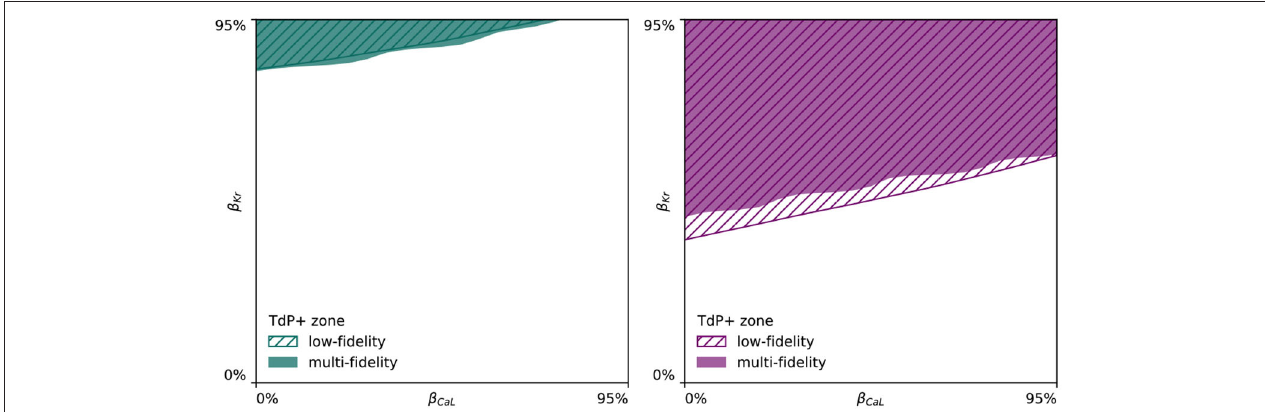
FIGURE A5 | Low- vs. multi-fidelity arrhythmogenicity mismatch. Mismatch between the low-fidelity midwall cell proxy and the full high-fidelity multiscale simulations for arrhythmogenic risk classification. For the male arrhythmogenic risk classification (Left) , this mismatch is limited. For the female arrhythmogenicity classification (Right) , the multi-fidelity classifier predicts arrhythmogenesis at larger { I Kr , I CaL } channel blocking combinations than the low-fidelity risk